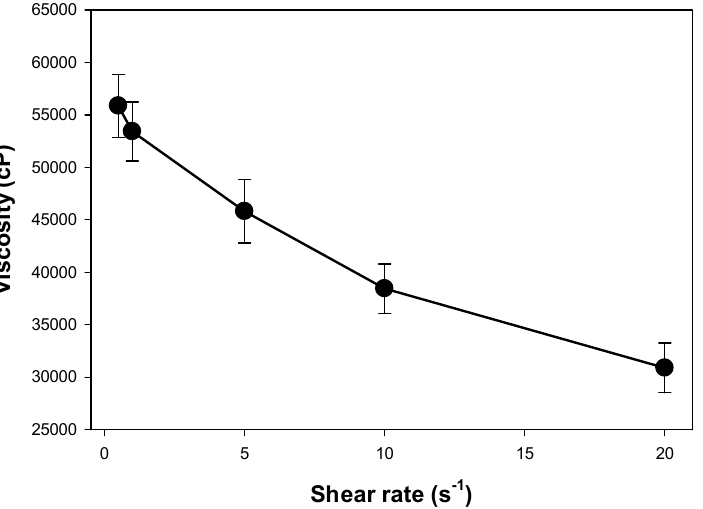
Figure 6. Apparent viscosity ( η ) vs shear rate of TBN-CSNP loaded P407 gel. Each value represents the mean ± S.D ( n = 3) .